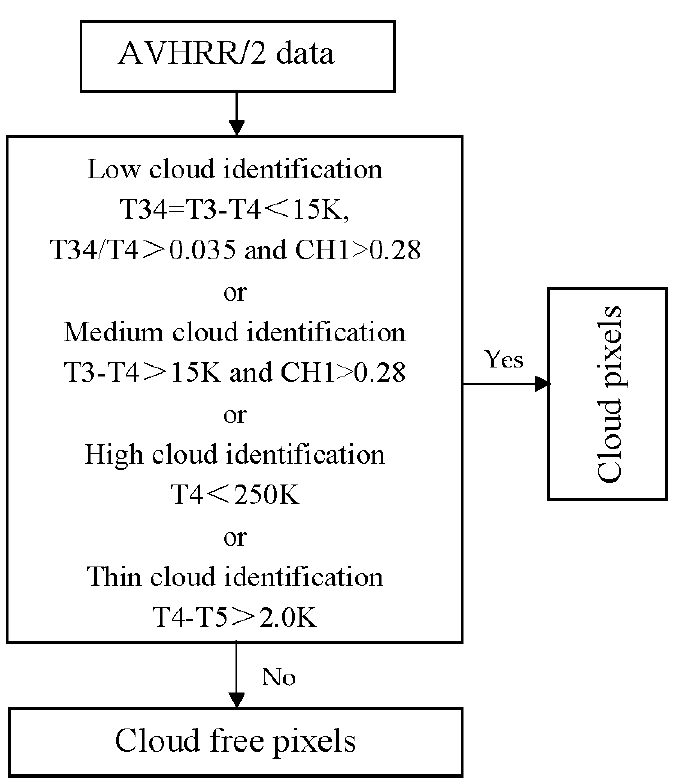
Figure 2. The flow chart of cloud detection in AVHRR/2 images (CH1, T3, T4, and T5 are the pixel values of Channels 1, 3, 4, and 5, respectively).